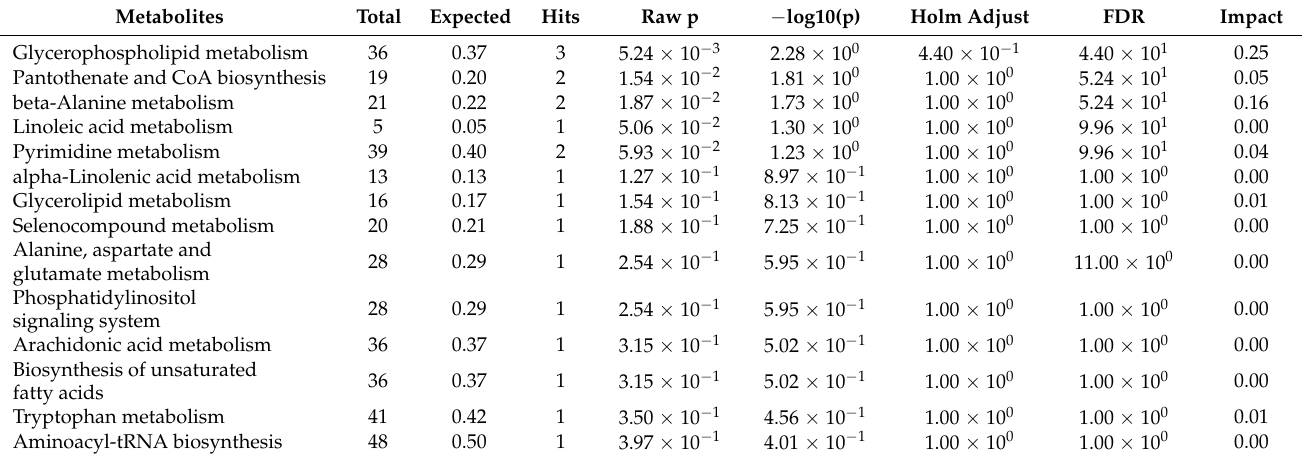
Table 2. A summary of the detailed results from the pathway analysis for female patients. We tested many pathways at the same time, and the statistical p values from enrichment analysis were further adjusted for multiple testings. From the table, the “Total” in the table is the total number of compounds in the pathway; the “Hits” is the actually matched number from the user uploaded data; the “Raw p” is the original p value calculated from the enrichment analysis; the “Holm p” is the p value adjusted by Holm-Bonferroni method; the “FDR p” is the p value adjusted using false discovery rate; the “Impact” is the pathway impact value calculated from pathway topology